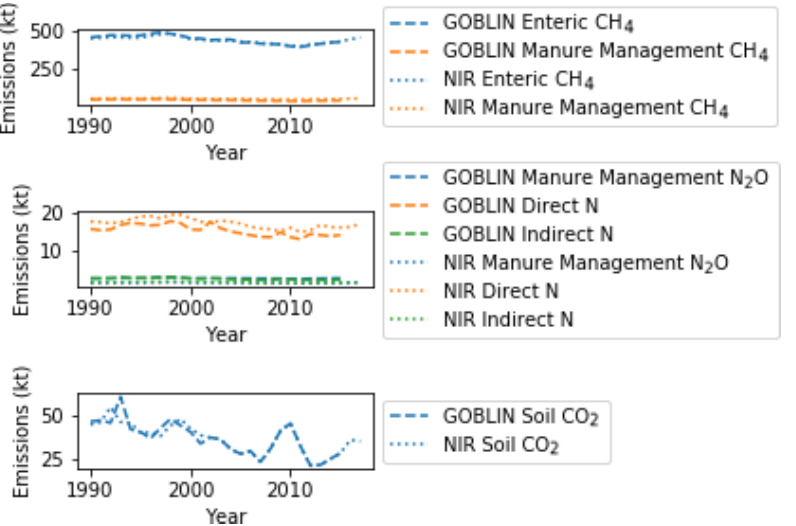
Figure 8. Comparison of agricultural GHG fluxes computed by GOBLIN with those reported in national inventory reports and derived from the same activity data for 1990 to